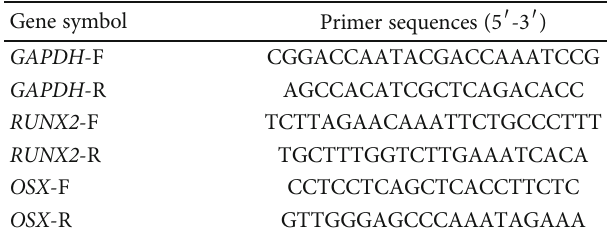
Table 1: Primer sequences used in the real-time